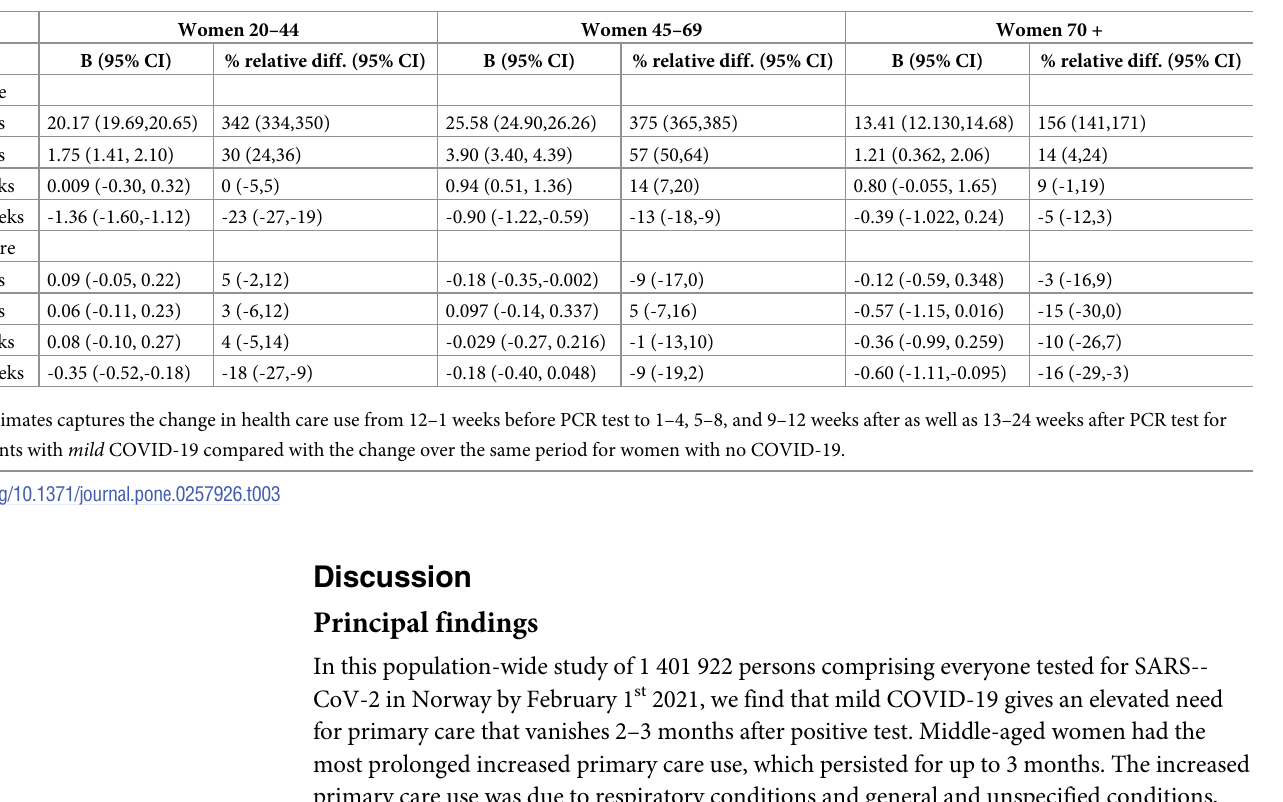
Table 3. Difference-in-differences (DiD) estimates of impacts of COVID-19 on health care use from 12–1 weeks before PCR test for SARS-CoV-2 to 1–4, 5–8, and 9–12 weeks after as well as 13–24 weeks after PCR test.